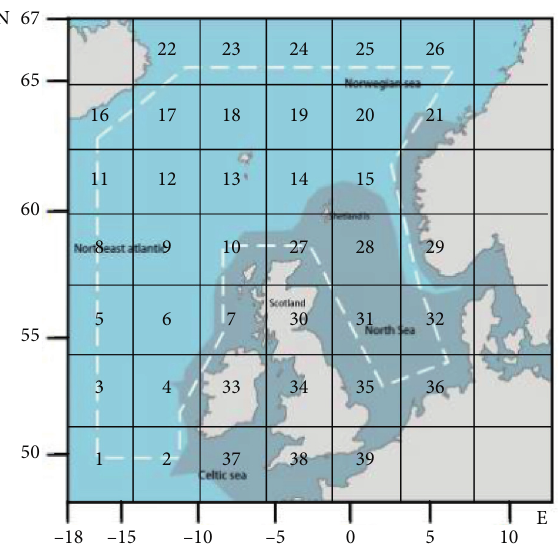
Figure 5: Target research sea area